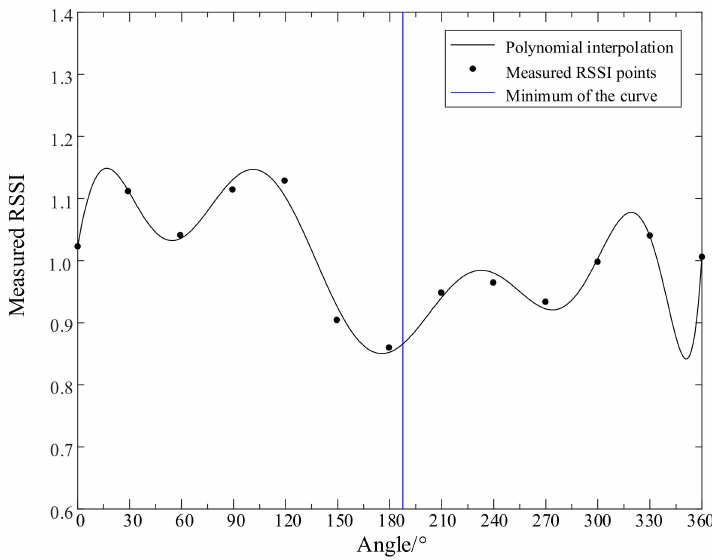
Figure 14. Diagram of polynomial interpolation.